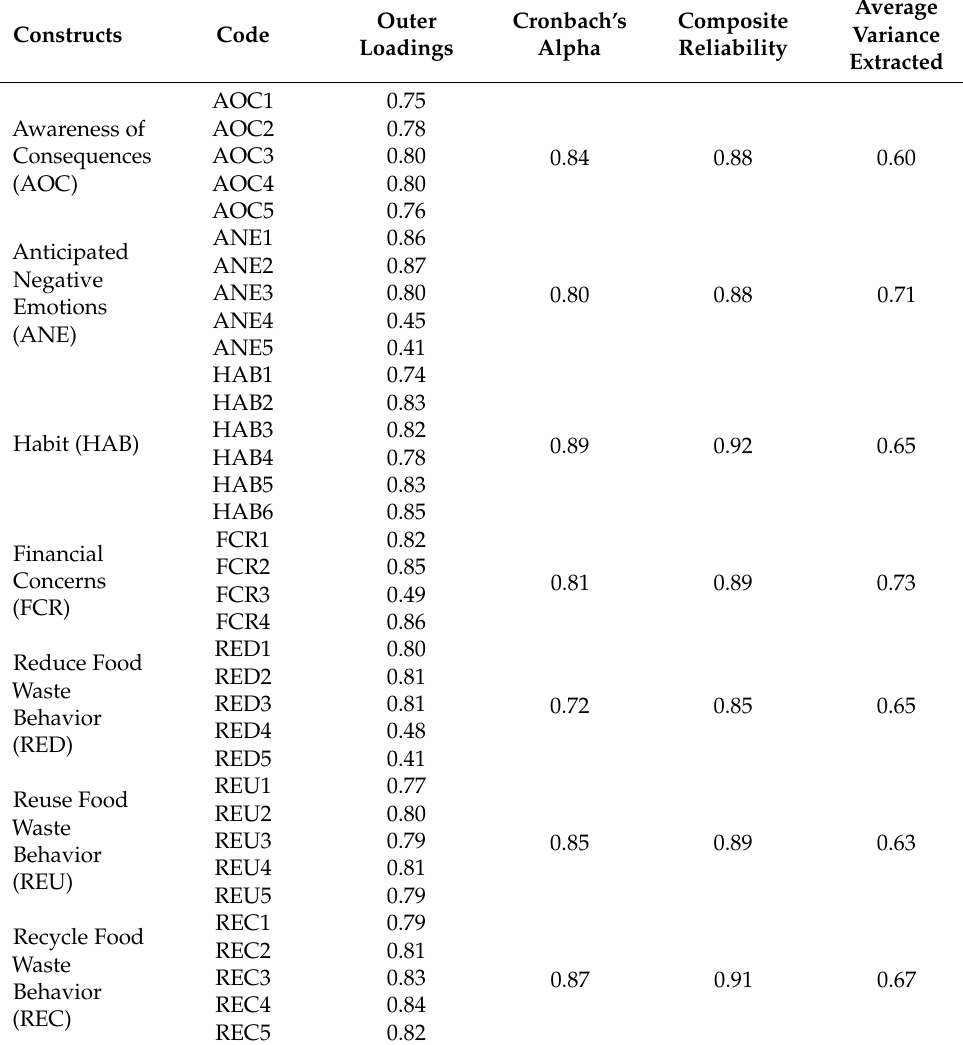
Table 2. Result of Measurement